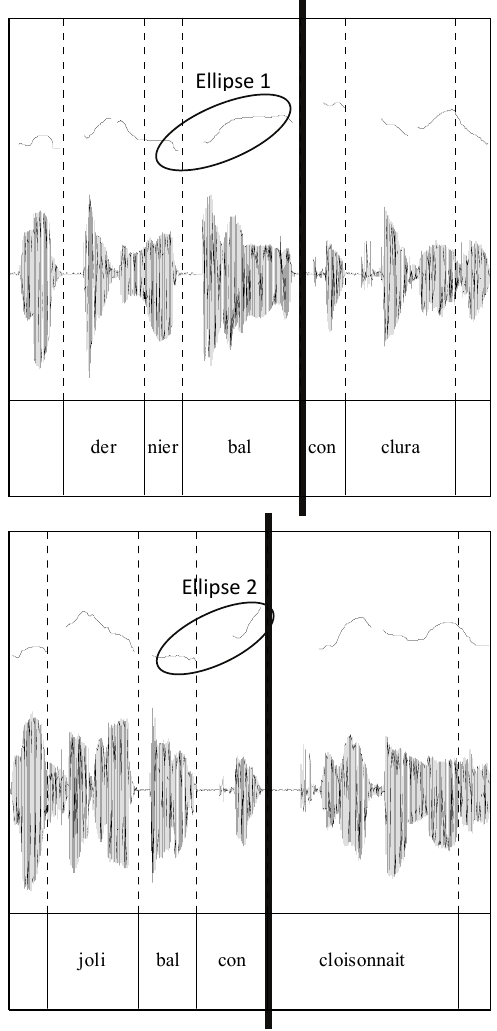
Figure 1: Waveform and fundamental frequency graph. The ‘bal][con’-sentence is represented at the top and the ‘balcon’-sentence at the bottom. The black bars show the position of the phonological phrase boundaries. The pitch rise at the end of a phonological phrase can be seen in ellipses 1 and